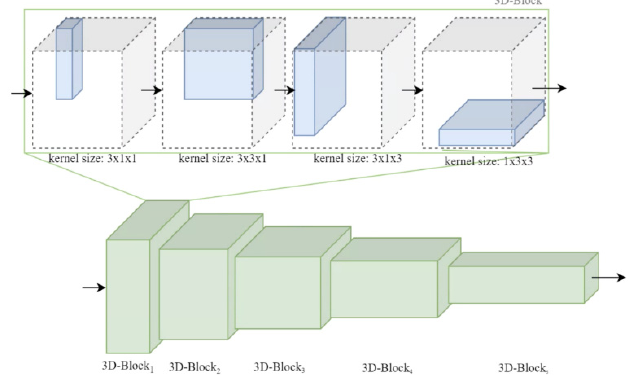
Figure 4. 3D CNN constructed by five 3D-Blocks each consisted of 4 different 2D kernels.